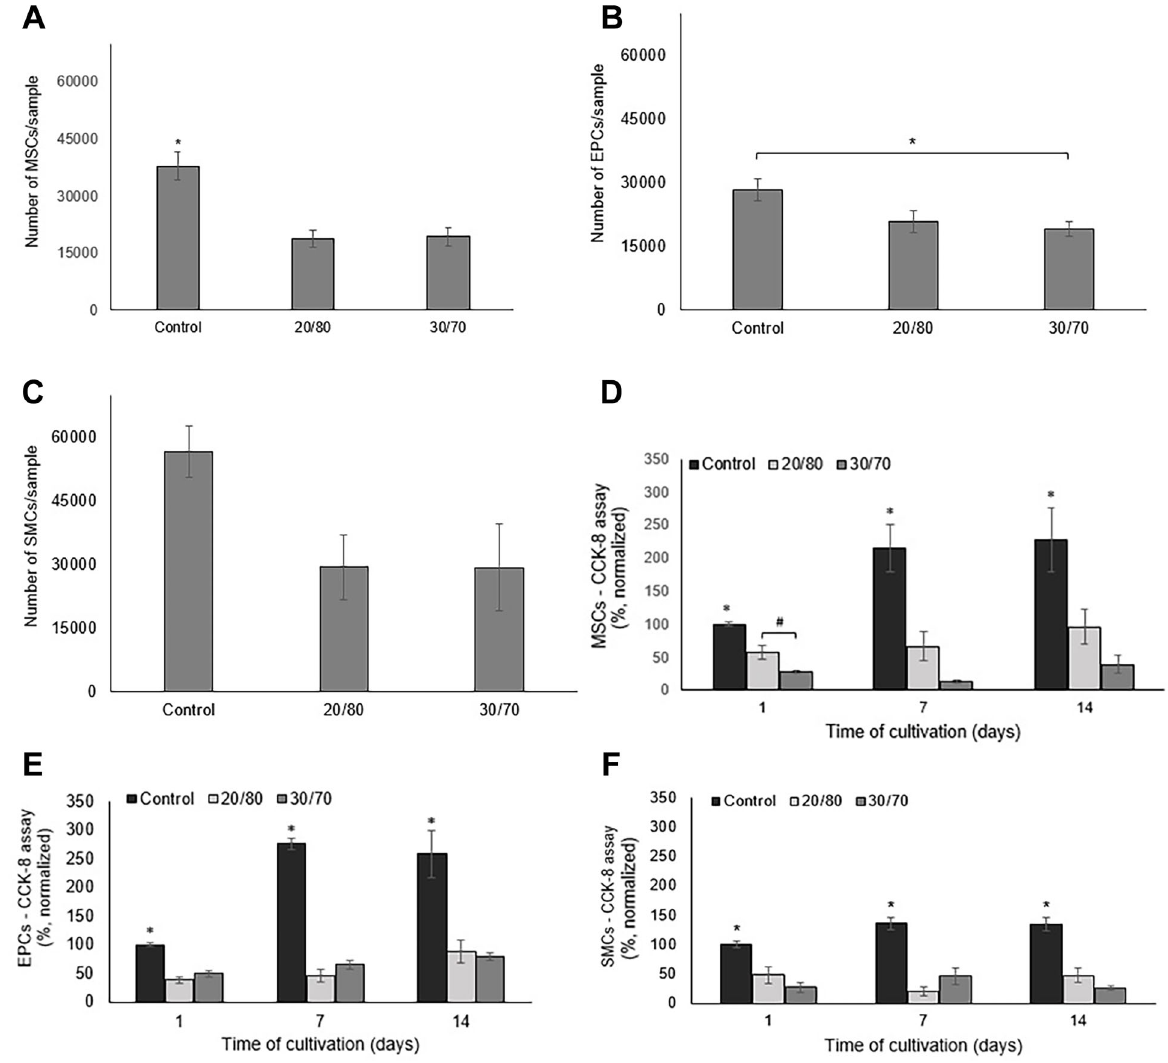
Figure 4. Adhesion of mesenchymal stem cells (MSCs) ( A ), endothelial progenitor cells (EPCs) ( B ), and smooth muscle cells (SMCs) ( C ) in the electrospun poly(trimethylene carbonate- co -L-lactide) (PTMCLLA) 20/80 and 30/70 scaffolds and in the culture plate (control group) after 3 h of incubation. Viability of MSCs ( D ), EPCs ( E ), and SMCs ( F ) during 14 days of cultivation in the scaffolds and in the culture plate. Data are reported as means ± SD. *P o 0.05 between the control and the other groups, # P o 0.01 between the PTMCLLA 20/80 and 30/70 groups (ANOVA followed by Tukey ’ s